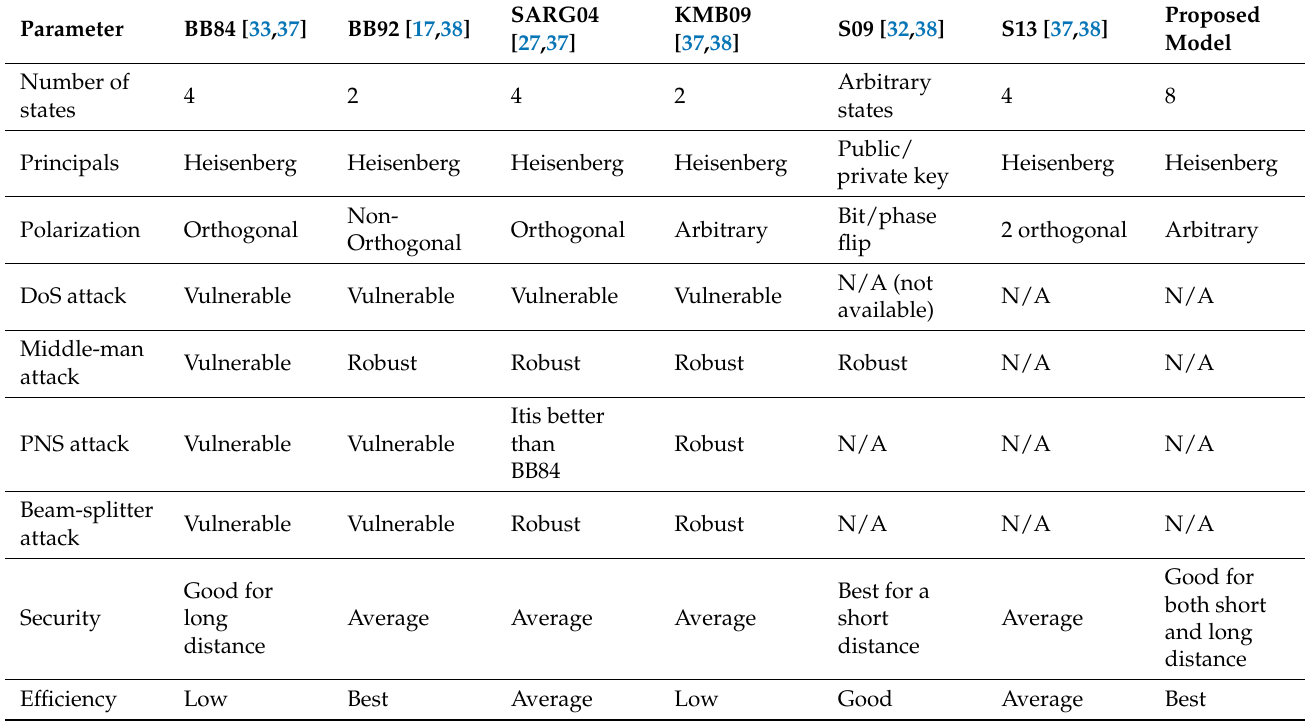
Table 1. Comparative analysis of existing QKD